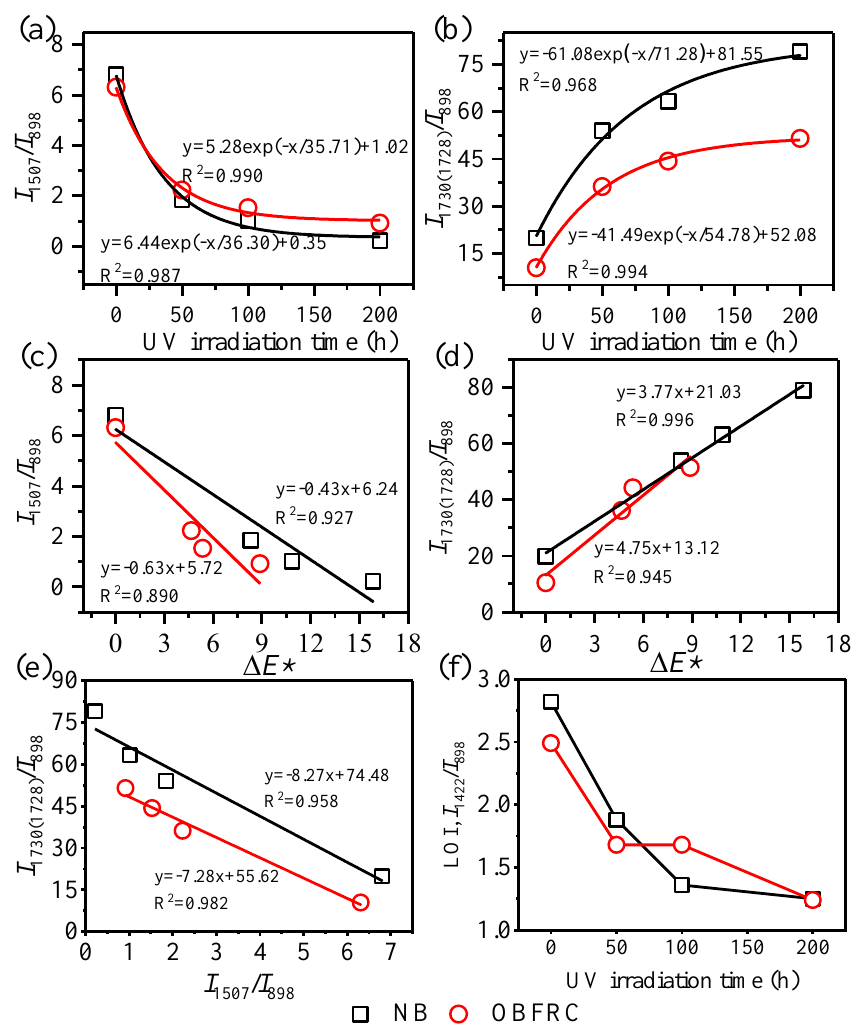
Figure 7. FTIR-ATR Analysis during photodegradation of NB and OBFRC. ( a , b ) Variation of lignin Figure 7. Variation of lignin decay (reference peak at 1507 cm − 1 ), carbonyl group formation (refer- decay (reference peak at 1507 cm − 1 ), carbonyl group formation (reference peaks at 1730 cm − 1 ence peaks at 1730 cm − 1 and 1728 cm − 1 ) and crystallinity ( I 1422 / I 898 ) during photodegradation of NB and 1728 cm − 1 ). ( c , d ) Correlation between color changes ( ∆ E *) and decay of lignin decay, and and OBFRC. carbonyl group formation. ( e ) Correlation analysis between the carbonyl formation and lignin decay. ( f ) Variation of crystallinity ( I 1422 / I 898